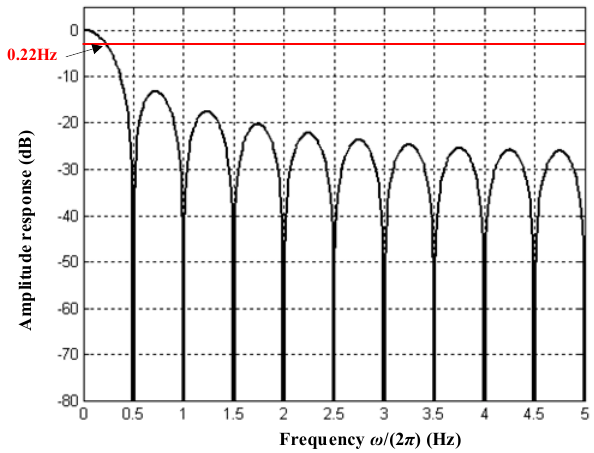
Figure 5. The amplitude-frequency response of the designed digital filter.